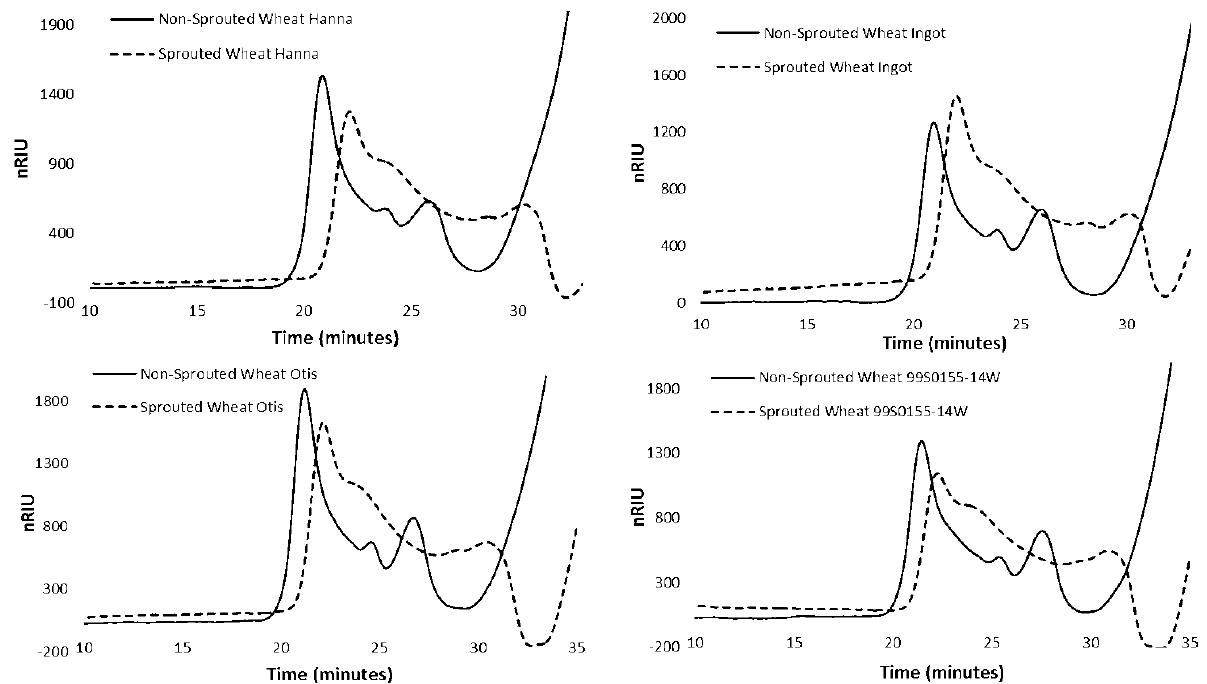
Figure 2. High Performance Size Exclusion Chromatograph (HPSEC) profiles of sound and PHS damaged wheat samples of genotypes Hanna and Ingot (hard red spring wheat genotypes), Otis and 99S0155-14W (hard white spring wheat genotypes). Dashed line represents the HPSEC chromatography of pre-harvest sprouting (PHS) damaged sample; solid line represents the HPSEC chromatography of sound